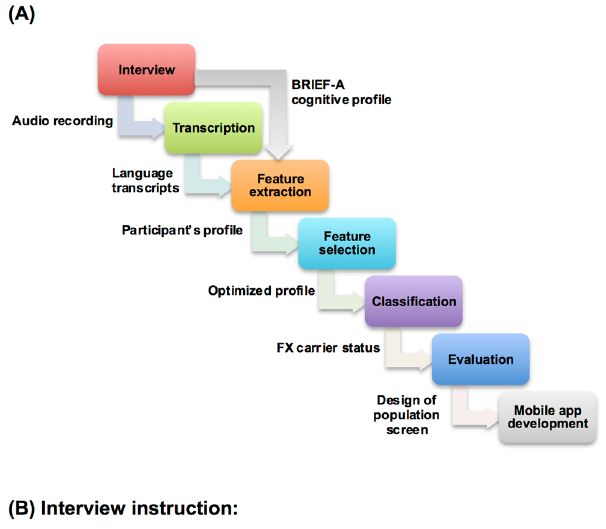
Figure 1. Workflow overview and language sample instruction. ( A ) The workflow for this project starts with data collection via phone or in-person interviews. Five-minute language samples were generated in response to interview instruction shown in ( B ) as previously described 11 . The audio recordings were transcribed and a text- processing module was used to extract linguistic features from the resulting transcripts. In parallel, cognitive profiles were collected using a cognitive self-assessment based on BRIEF-A standard 32, 33 . Then, a comprehensive profile was generated using the combination of linguistic and cognitive features. For the machine learning portion of the study, a feature selection module was implemented to choose the most informative features based on the information gain score. A classifier was developed to determine the FX premutation status. Finally, the results of evaluation were used to determine the feasibility of improving data collection process. A mobile app based on these results was developed to expand the